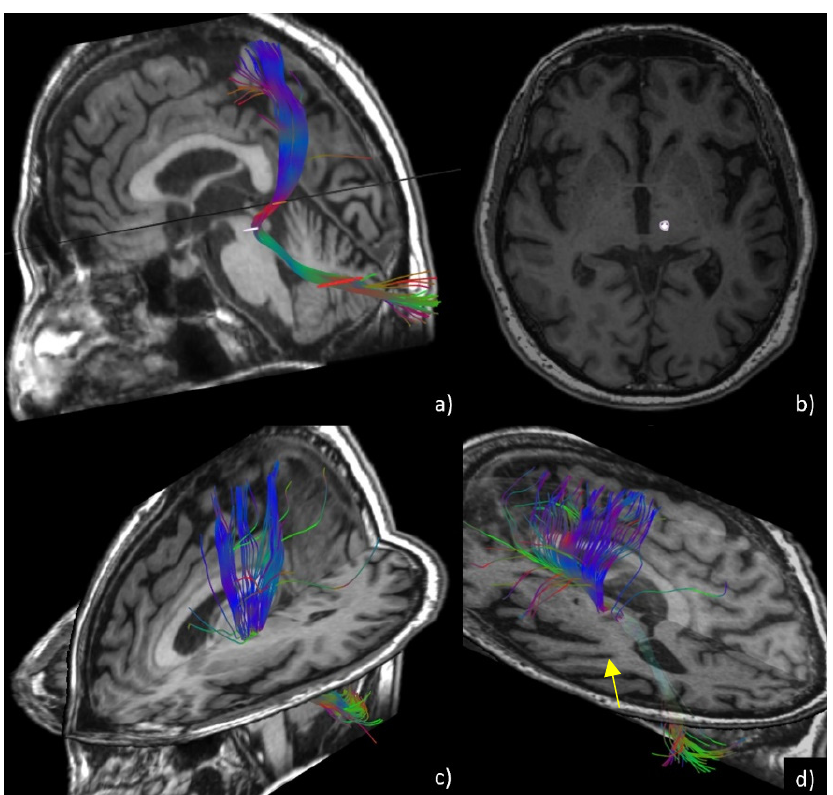
Figure 1. DTI tractography of the DRTt (dentato-rubro-thalamic tract). In ( a ), 3D reconstruction of the fiber bundle is shown through ROI seeding, superimposed on the volumetric T1 sequence at the levels of the dentate nucleus, red nucleus, and thalamus. In ( b ), ROI position of the DRTt at the level of the thalamus is shown, for quantitative analysis of ADC and FA values. In ( c ) and ( d ), central/eccentric location of the DRTt is shown. The bundle is centered within the lesion in c while appearing eccentric with respect to the hypointense thalamotomy lesion (arrow) in ( d